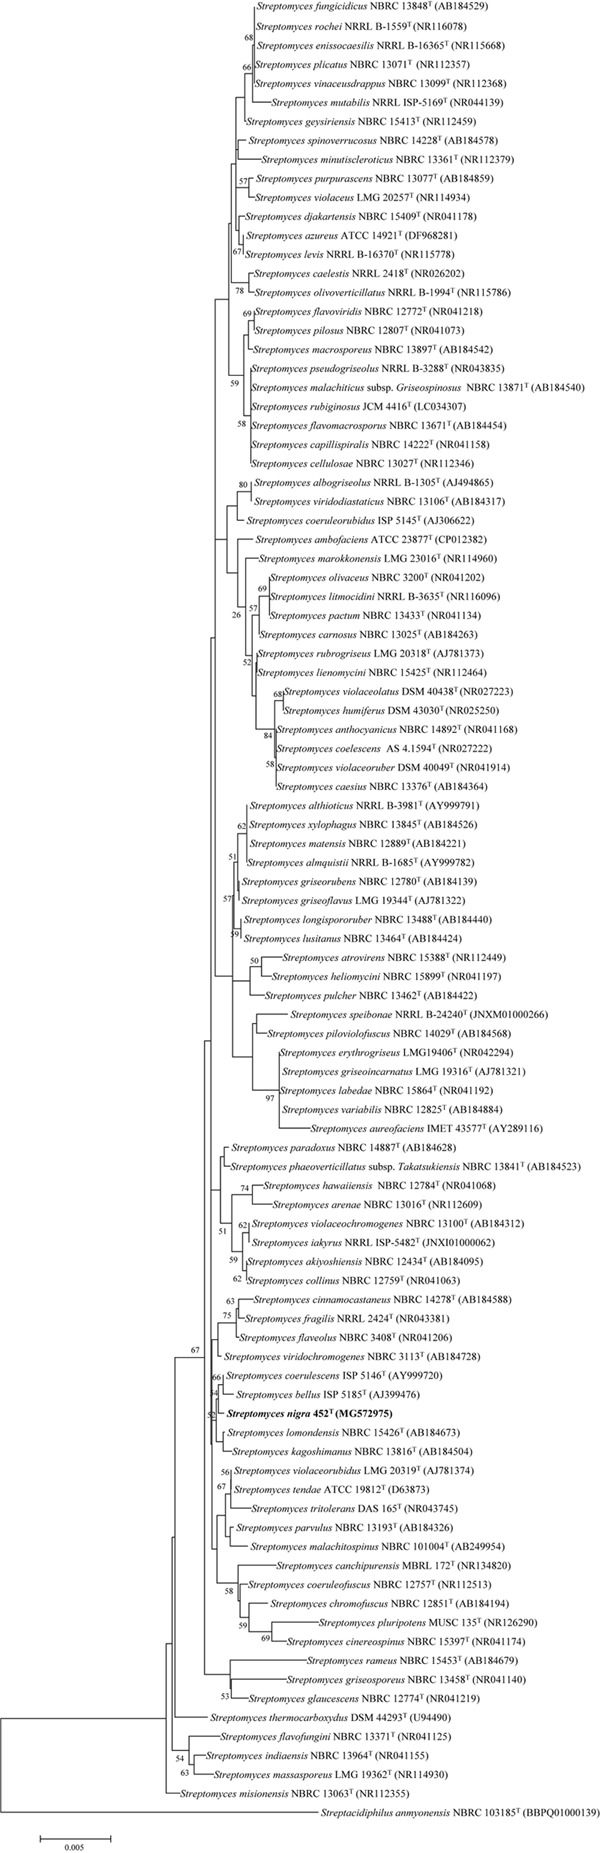
Neighbor-joining phylogenetic tree based on the 16S rRNA gene sequences of strain 452T and representatives of related taxa. Bootstrap values were expressed as a percentage of 1,000 replicates and only values >50% are shown at the branch points. Bar, 0.005 substitutions per nucleotide position.